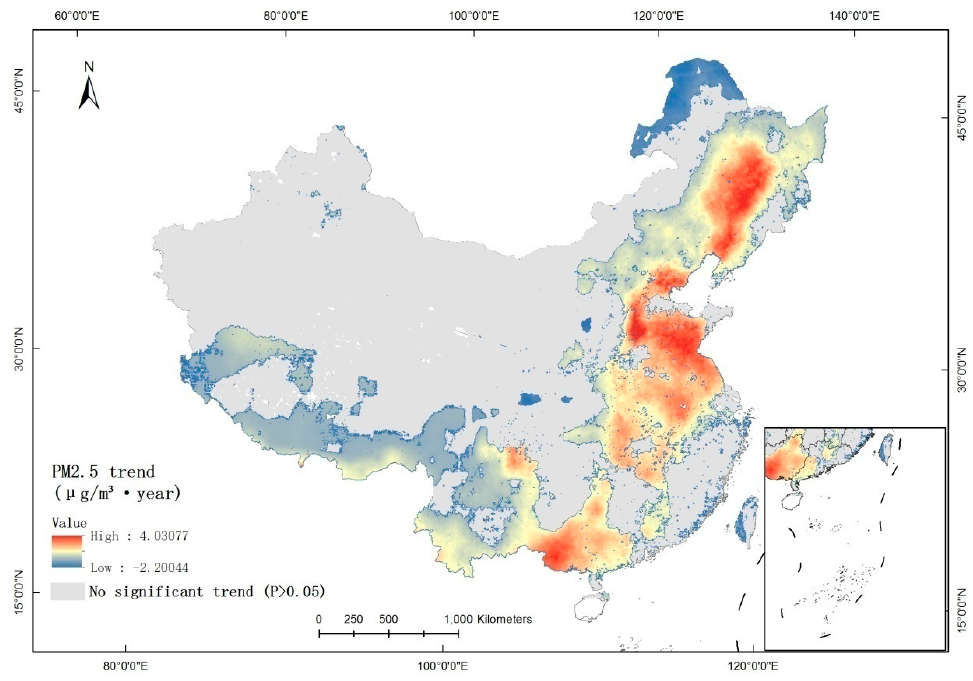
Figure 4. Significant trends of PM 2.5 in China during 2000–2015.